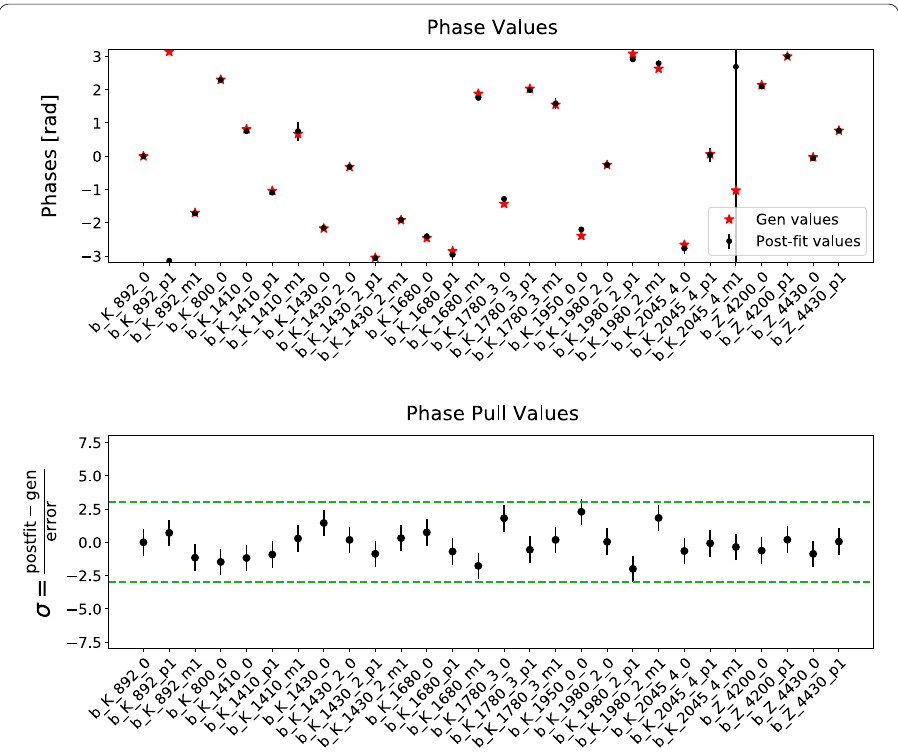
Fig. 12 Comparison of generated and post-fit values of the phase parameters (above) and the corresponding pull distribution (below) obtained from a fit to events generated with ten K ∗ s Z (4430) model including relative efficiency and 15% background contribution. The green lines define a ± 3 σ